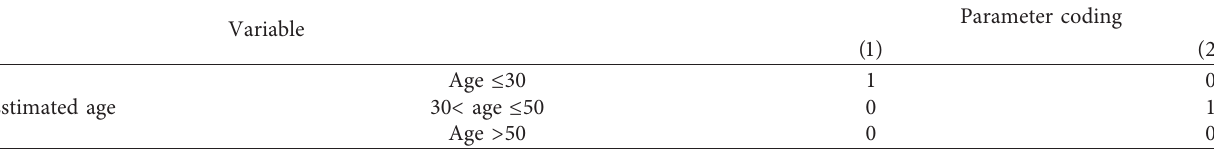
Table 7: Categorical variables coding.